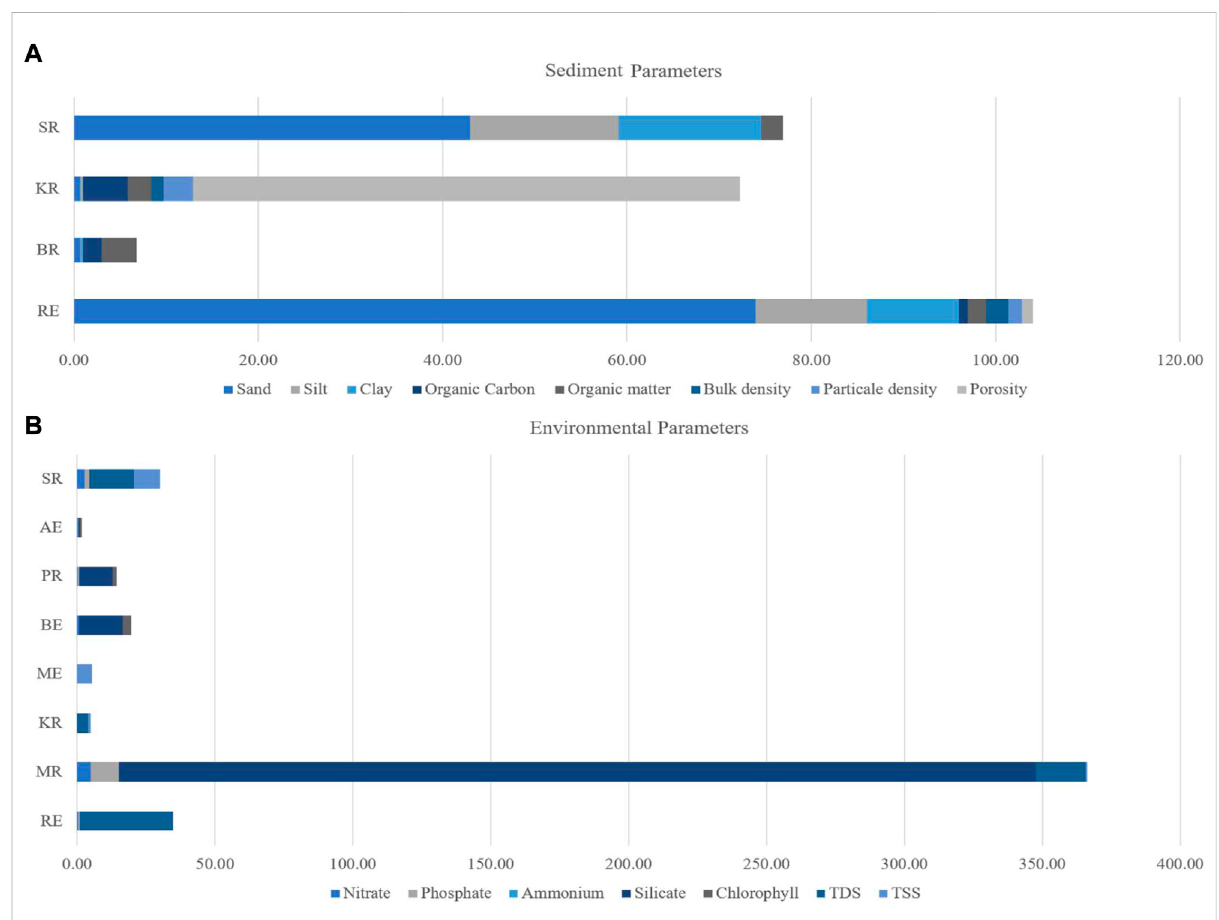
FIGURE 2 Comparative visualization of average sediment compositions (A) in various estuaries and comparative concentrations of